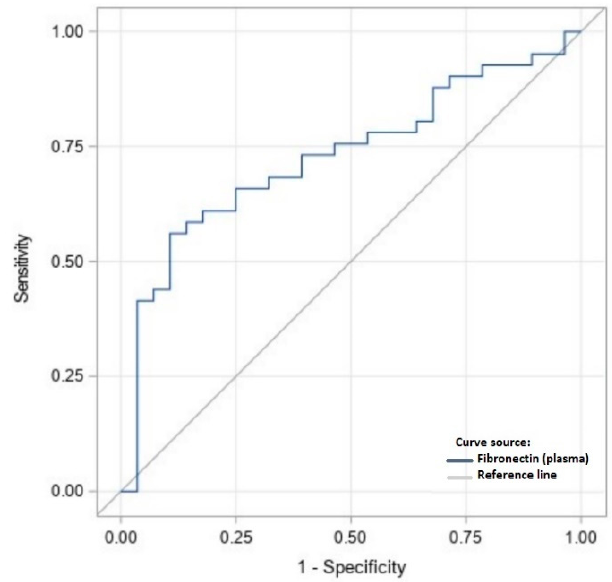
Figure 2. The ROC curve analysis for diagnostic efficacy of fibronectin in peritoneal fluid for endometriosis.